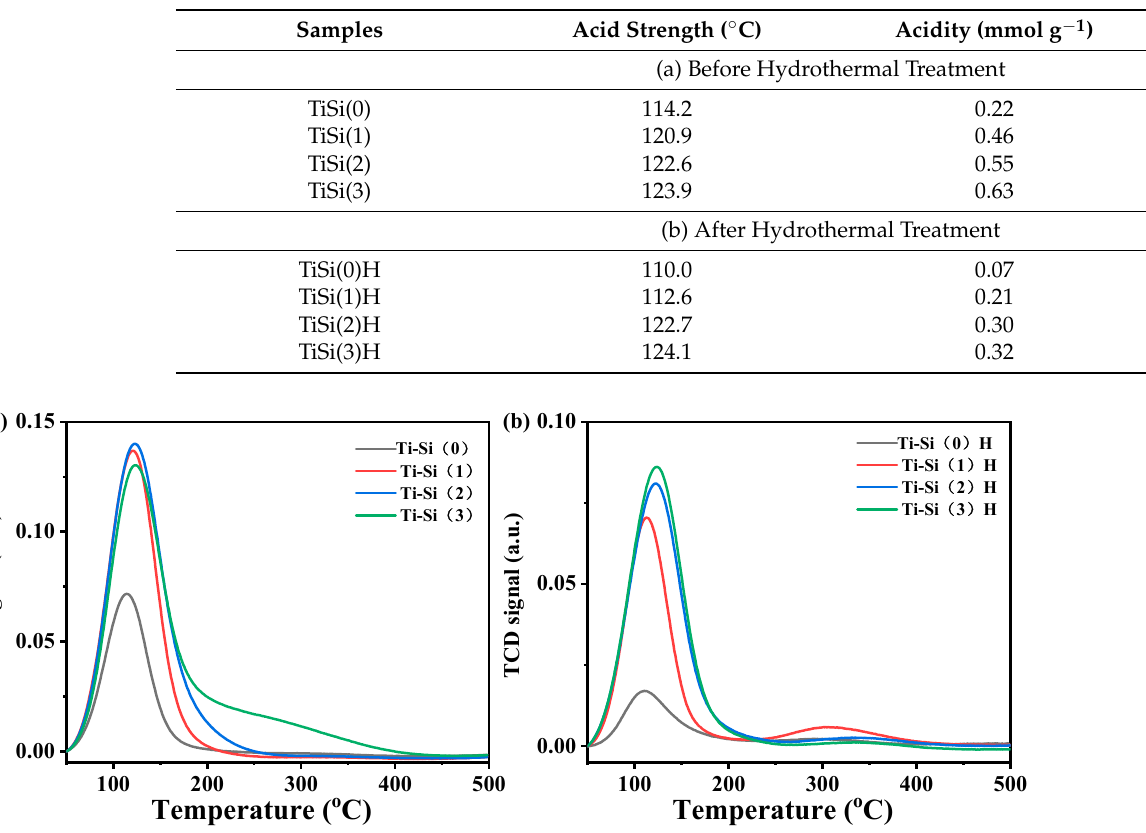
Table 3. NH3-TPD characterization results of mesoporous silica catalysts with different titanium